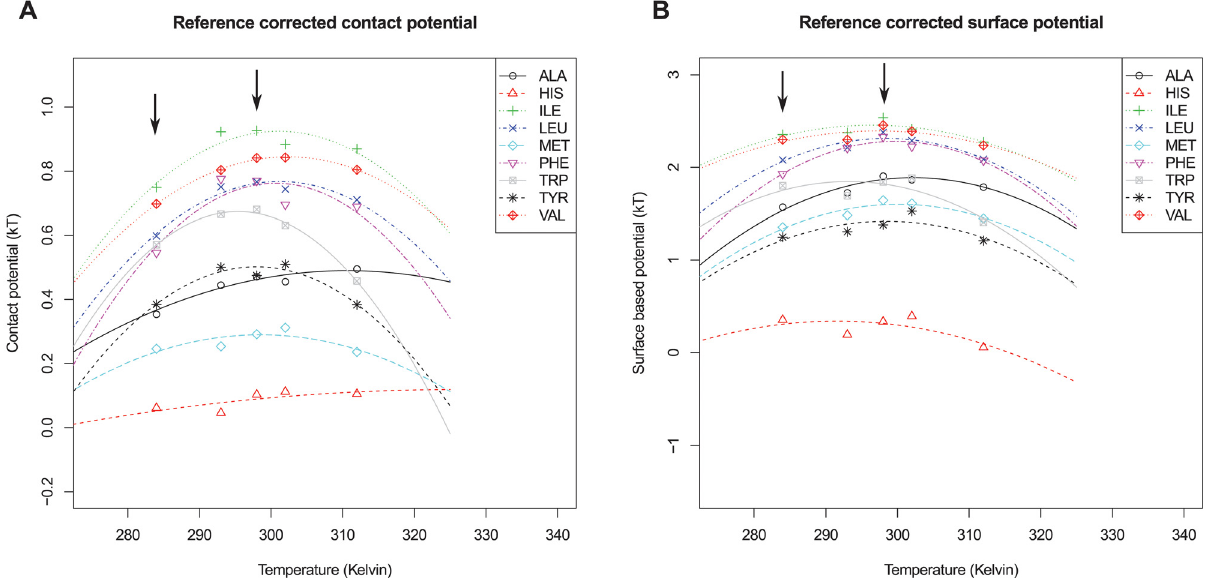
Fig 4. Reference corrected free energies of transfer for hydrophobic amino acids. Contact based (A) and surface based (B) free energies are shown for hydrophobic and aromatic amino acids. The free energies are corrected by setting a reference of the polar and charged amino acids. Points show the free energy estimates for each temperature bin and lines are fitted with a parabola. Arrows indicate the bins used to test the significance of the temperature dependence.